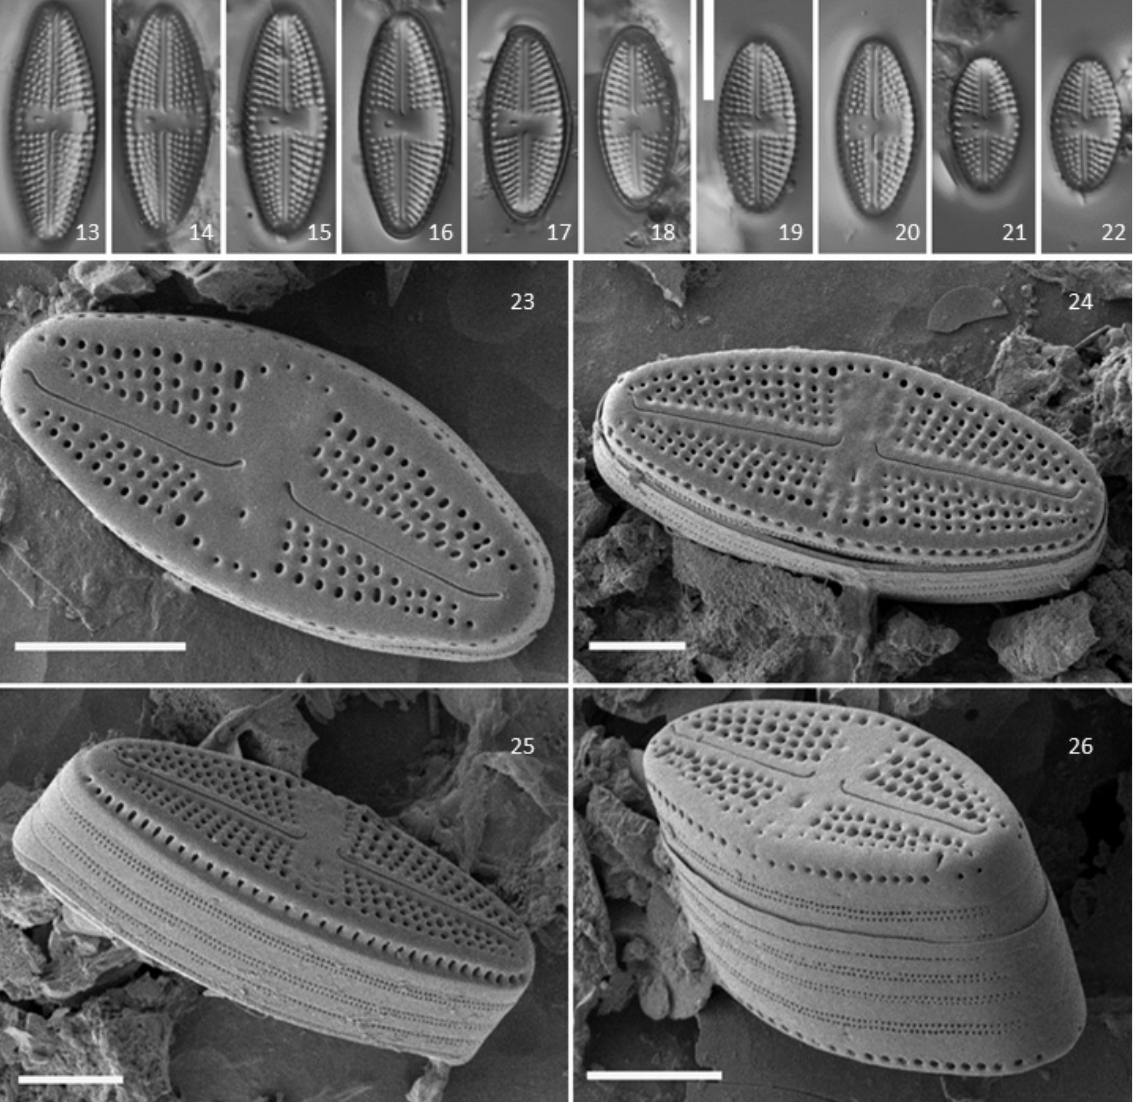
Figs 13–26. Luticola subcrozetensis Van de Vijver et al. Light (LM) and scanning electron micrographs (SEM) of a population from Ile Saint-Paul. 13–22 . LM of valve face views. 23–24 . SEM of external view showing composition of striae and typical raphe structure. 25–26 . SEM girdle view. Scale bars: 13–22 = 10 µm; 23–26 = 5